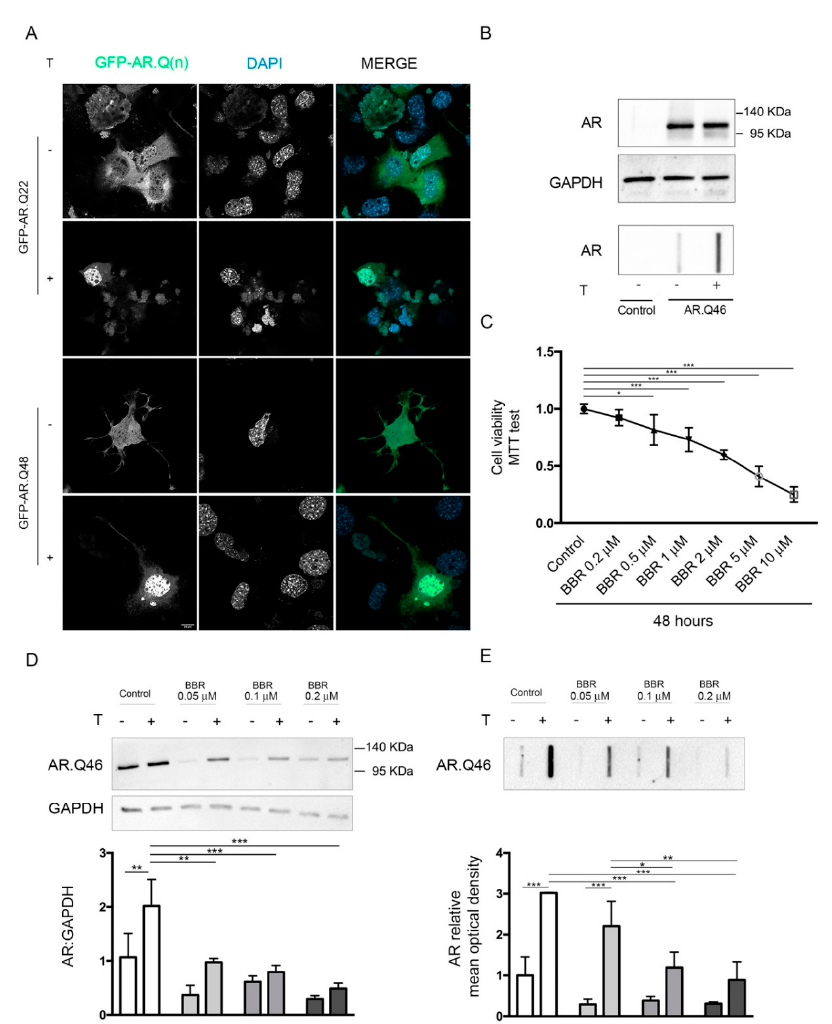
Figure 1. BBR reduced the ARpolyQ protein level. ( A ) Representative confocal microscopy analysis of GFP-AR.Q(n) intracellular localization. NSC34 cells were transfected with GFP-ARQ.22 or GFP-AR.Q48 in absence or in presence of 10 nM testosterone. Nuclei were stained with DAPI (63X magnification). Scale bar: 10 µ M. ( B ) WB analysis performed on NSC34 cells transfected with AR.Q46 in absence or in presence of 10 nM testosterone, untransfected control was added to test the antibody specificity. GAPDH was used as loading control. ( C ) MTT cell viability assay was performed on NSC34 cells treated with BBR at di ff erent concentration for 48 h (* p < 0.05, *** p < 0.001, one-way ANOVA, followed by Tukey’s test). ( D , E ) NSC34 cells were transfected with AR.Q46 in absence or presence of 10 nM testosterone and BBR at three di ff erent doses (0.05, 0.1, and 0.2 µ M for 48 h Ethanol and DMSO were used as vehicle control for testosterone and BBR, respectively. ( D ) WB analysis was performed. GAPDH was used as loading control, and the bar graph represents the mean optical density ± SD of AR: GAPDH (n = 3) ( E ) FRA was performed, the bar graph represents the mean optical density of AR ± SD (n = 3). (* p < 0.05, ** p < 0.01, *** p < 0.001, two-way ANOVA, followed by Tukey’s